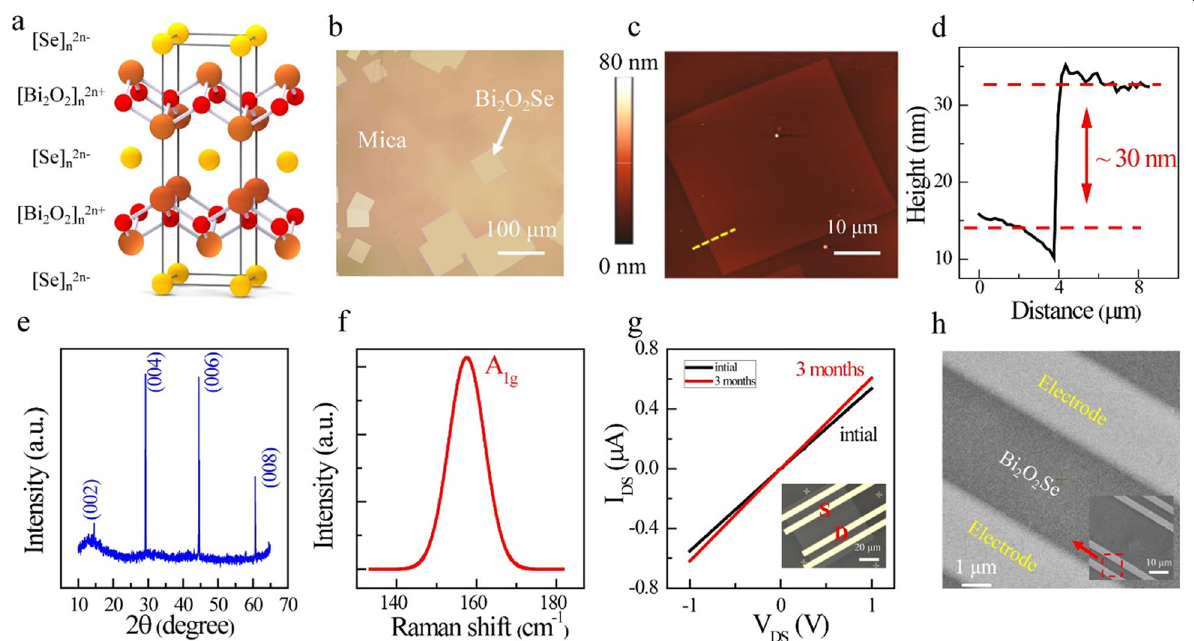
Fig. 1 Characterization of layered Bi 2 O 2 Se nanofilms. a Schematic of layered Bi 2 O 2 Se crystal structure. Orange ball: Bi. Red ball: O. Yellow ball: Se. b Typical optical image of as-grown